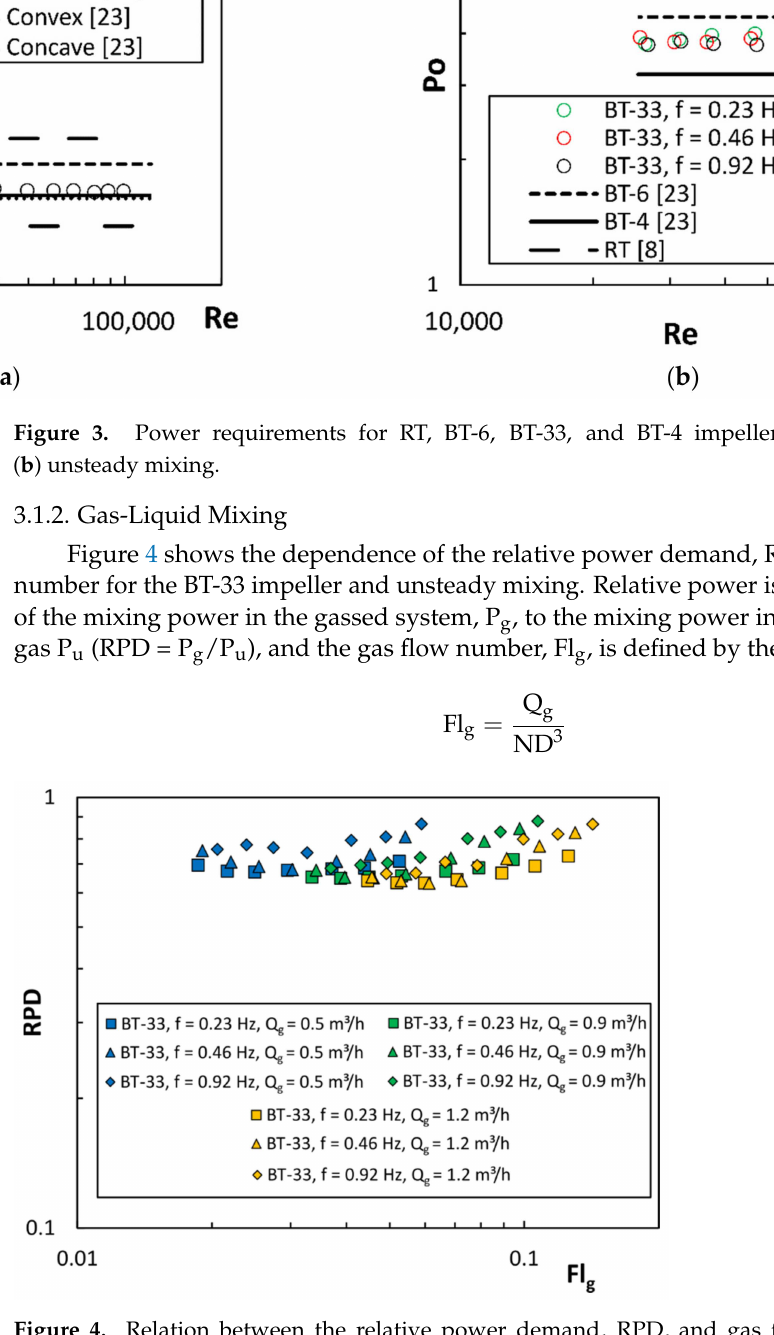
Figure 4. Relation between the relative power demand, RPD, and gas flow number, Fl g , for unsteady